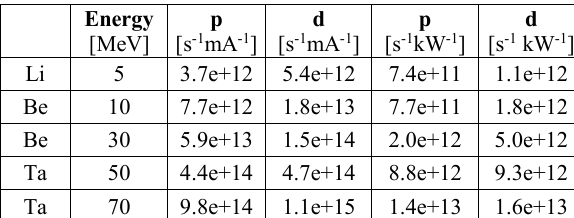
Table 2. Calculated total neutron yield for different targets, ion types and energies normalized to the ion current (columns 3, 4) as well as the source strength normalized to the average power at the target (columns 5,